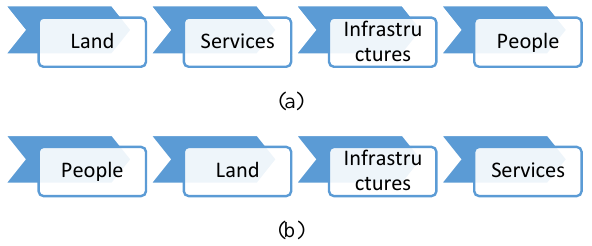
Figure 3. Flowchart showing intended (a), and involuntary (b) processes in planning